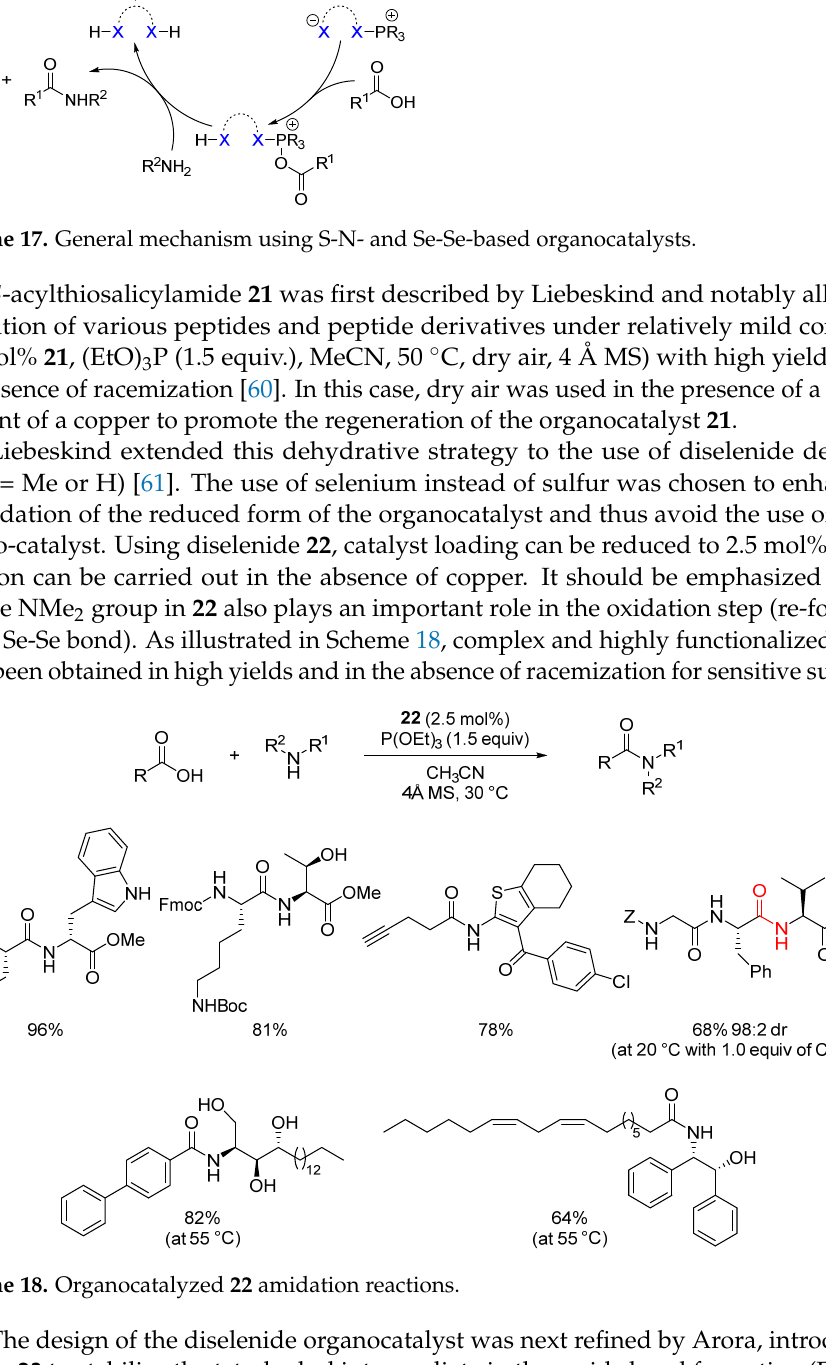
Figure 5. Urea ‐ stabilized tetrahedral intermediate using organocatalyst 23.